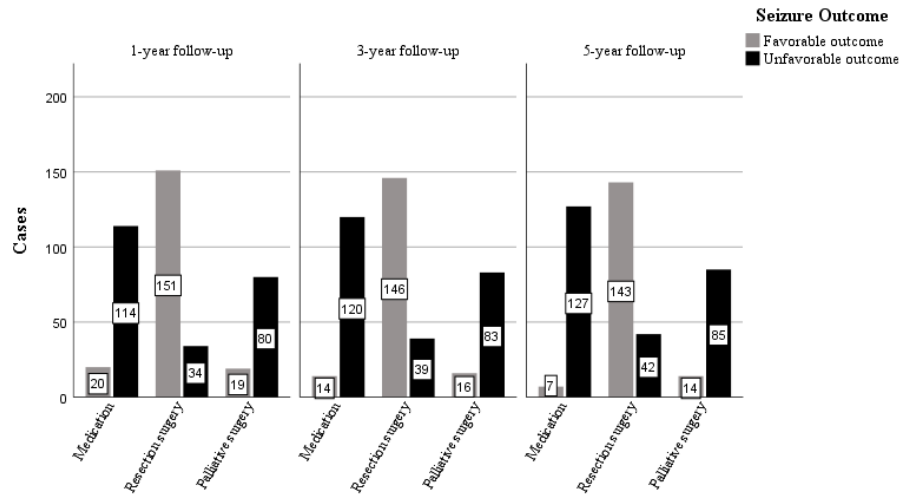
Figure 5. Number of patients with seizure outcomes according to different treatment regimens at different follow-up times.